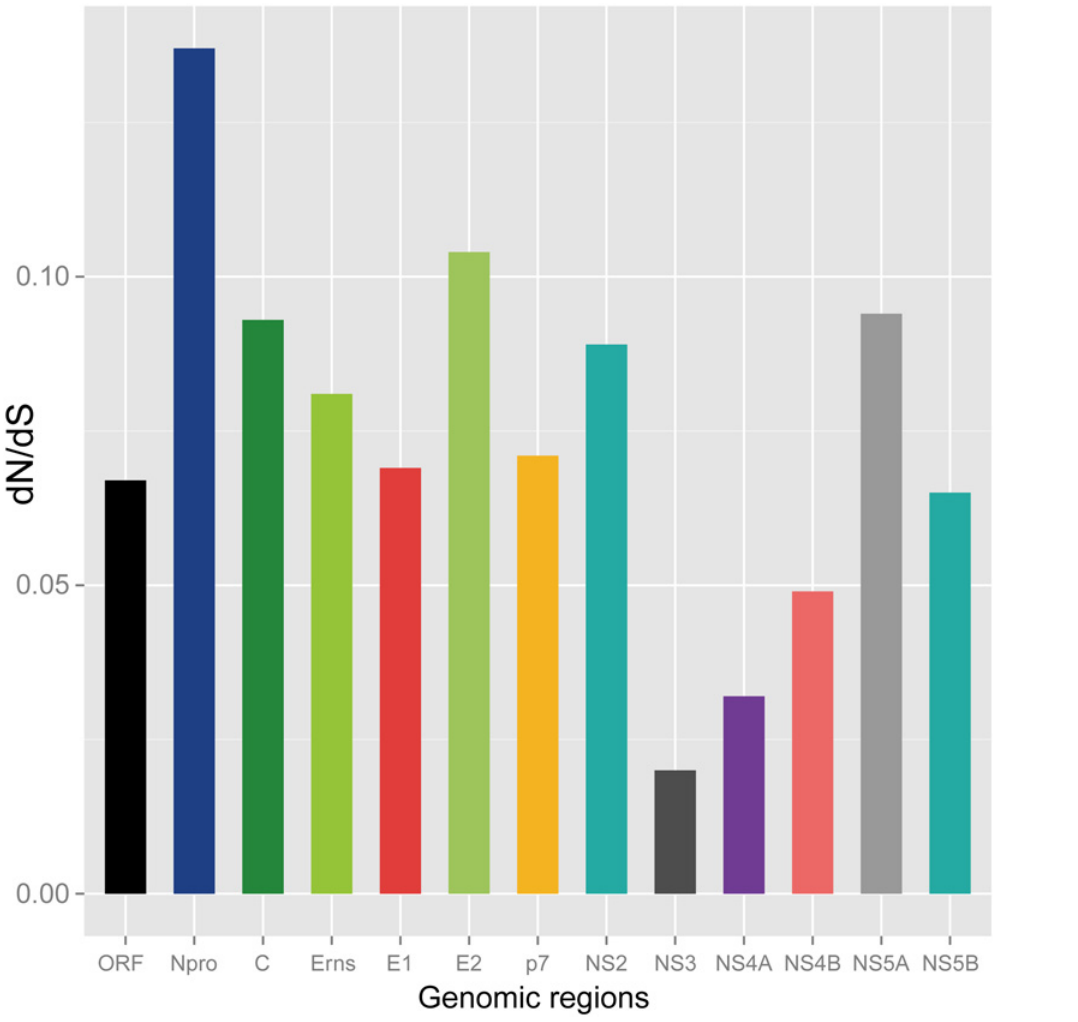
Fig 2. Pairwise dN/dS ( ω ) values of the protein coding gene sequences of 37